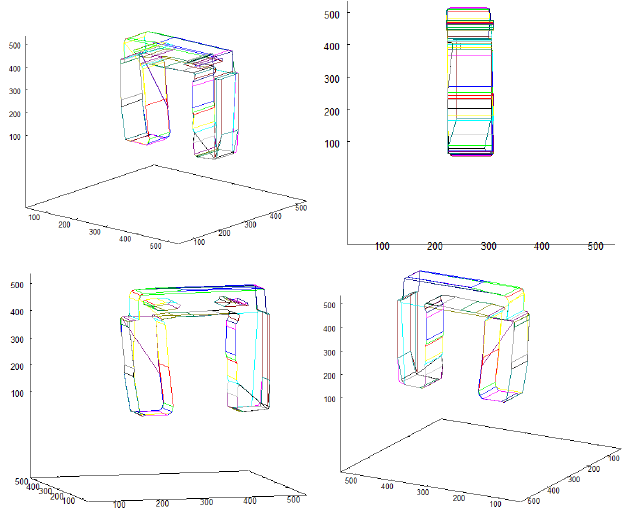
Figure 30. 3D model of examined object presented from different